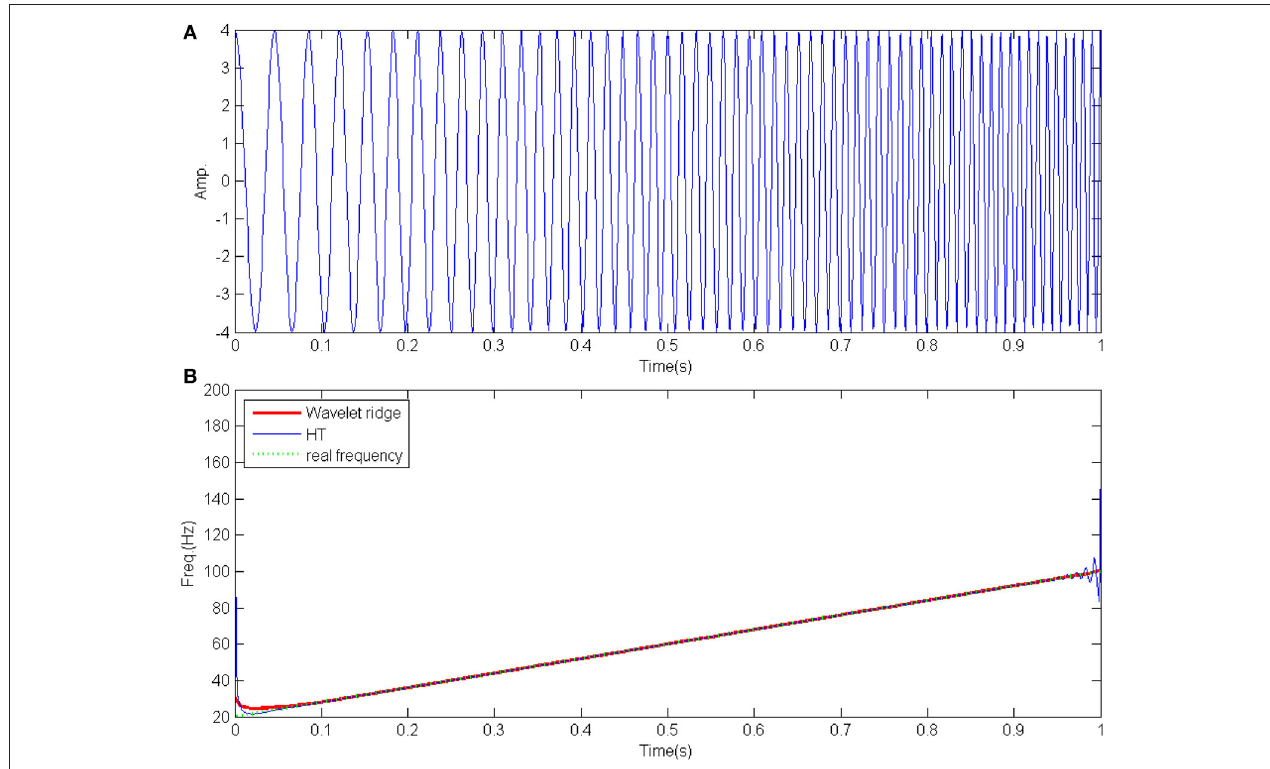
FIGURE 1 | EMD applied to the simulated signal without noise. (A) The simulated signal. (B) IF extracted respectively by wavelet ridge and HT. The real frequency is plotted in green color.